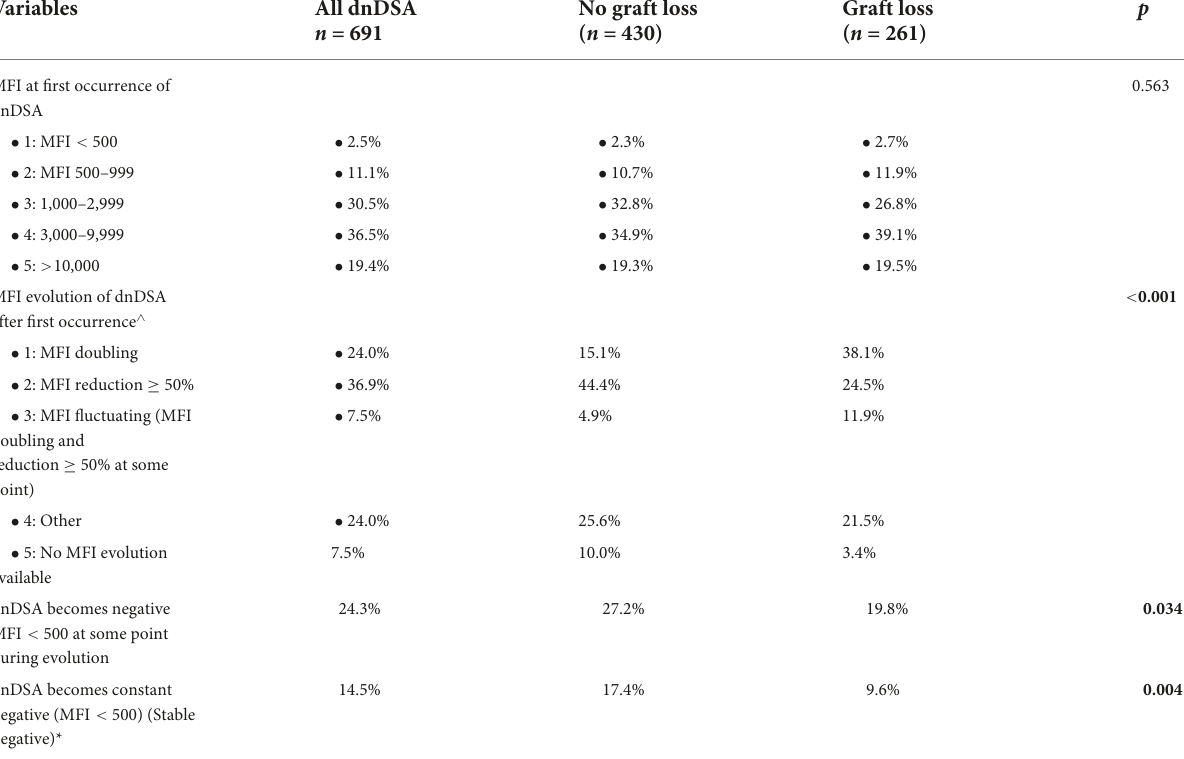
No graft loss ( n = 430)